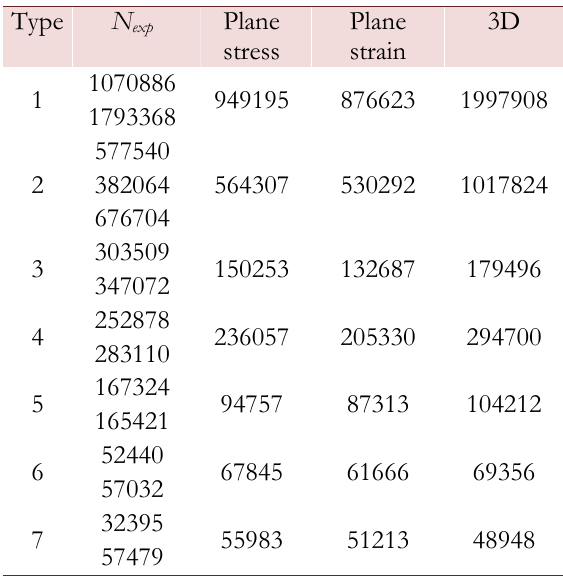
Table 3: Fretting fatigue life predictions.